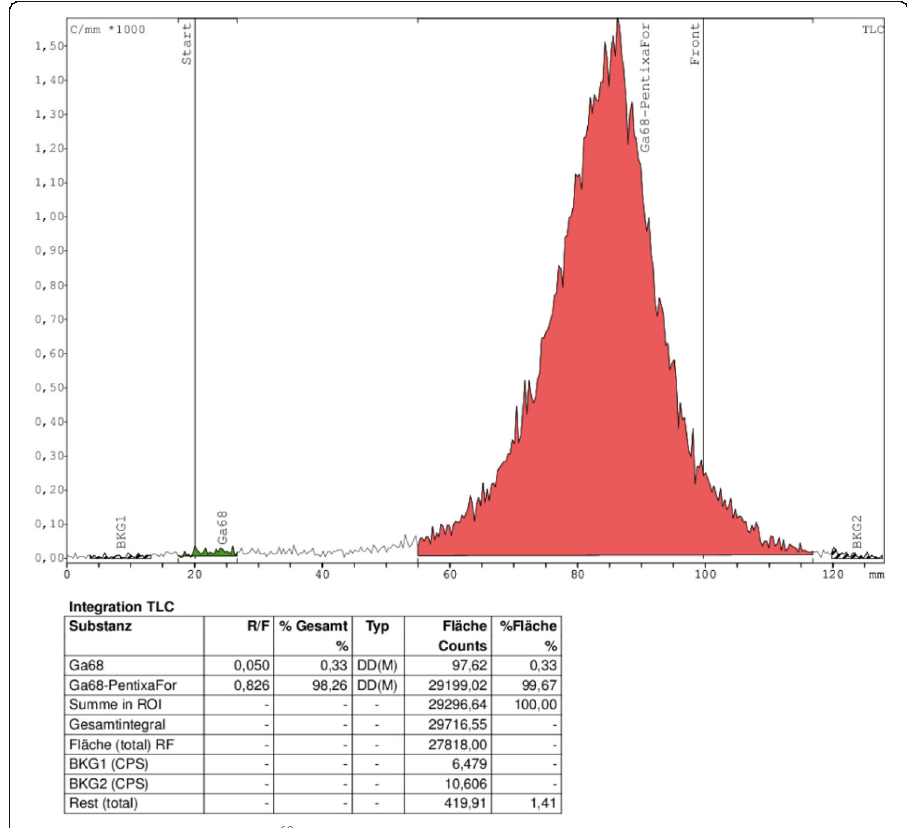
Fig. 4 iTLC- Chromatogram of [ 68 Ga]Ga-PentixaFor, 50 μ